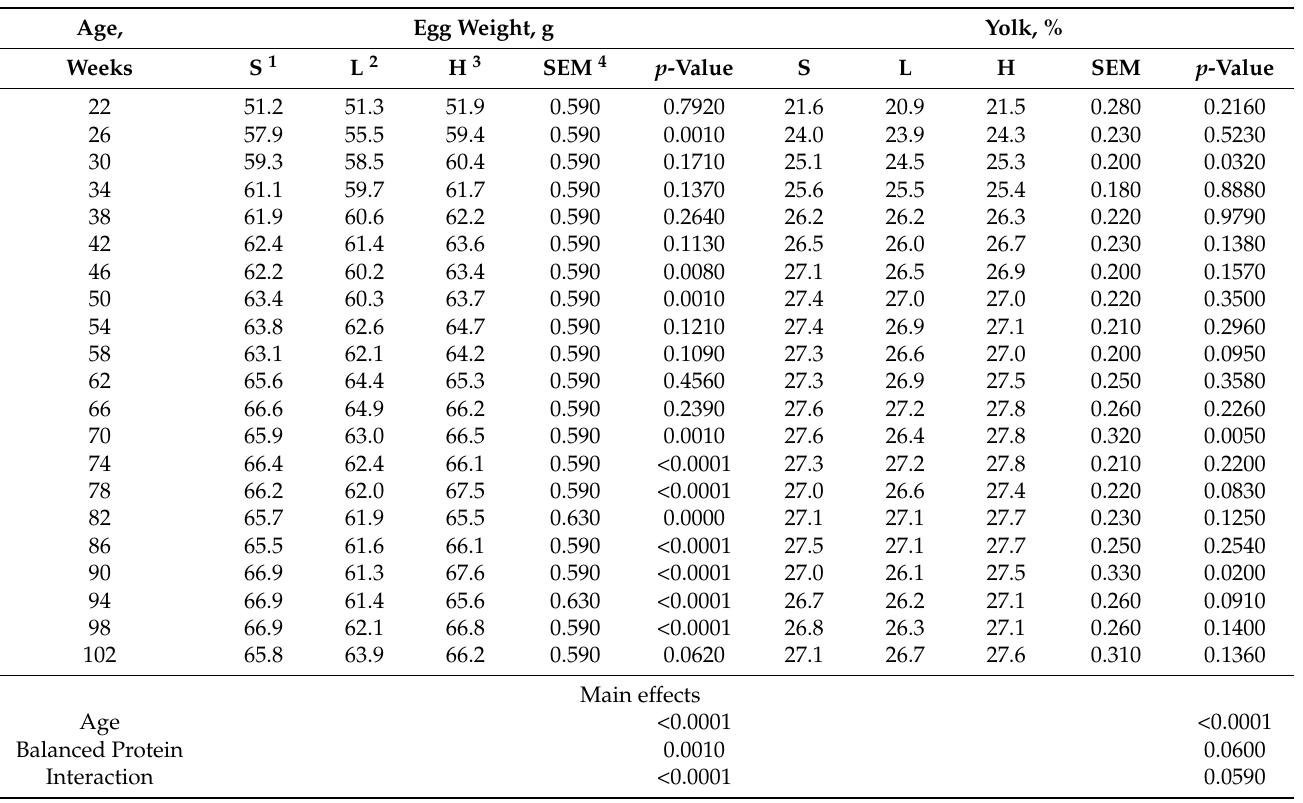
Table 9. Egg weight and egg components of laying hens from 19 to 102 weeks old in response to three dietary balanced protein